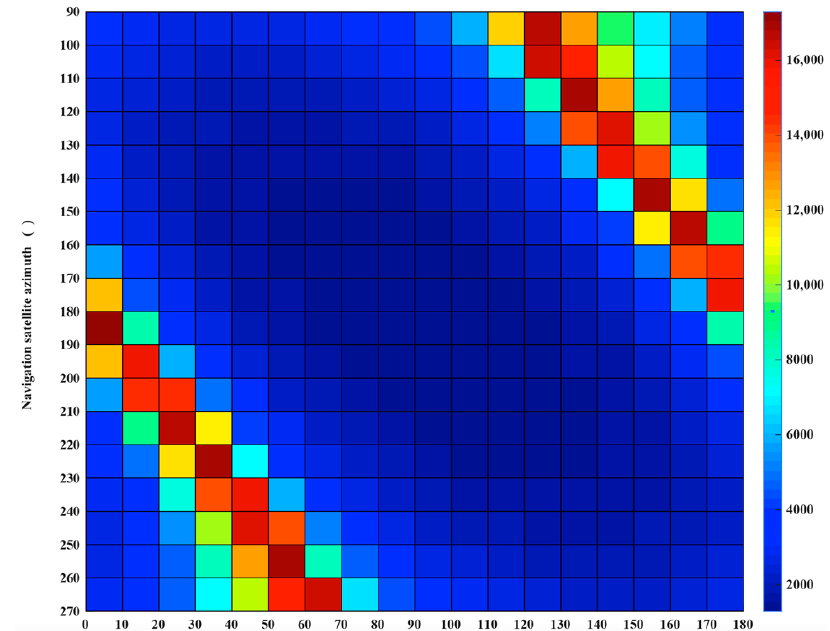
Figure 4. Two-dimensional (2-D) resolution unit area distribution of A 1 ( ϕ , γ ,45 ◦ )